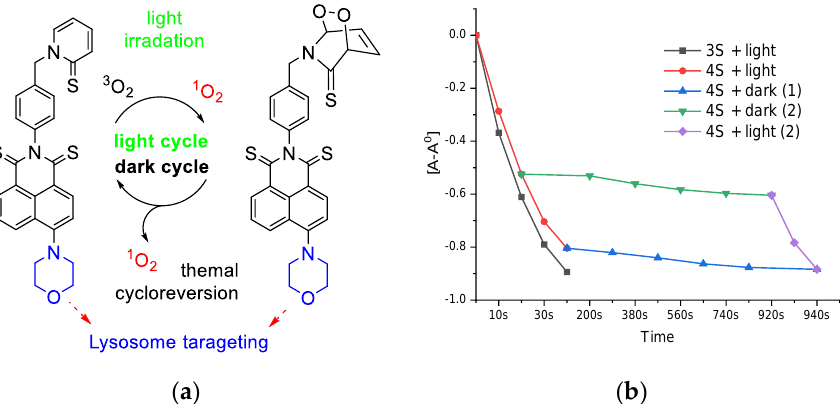
Figure 3. ( a ) Proposed mechanism of light/dark controlled release of lysosome-targeted heavy-metal-free PSs; ( b ) the decreased absorbance of DPBF ( 1 O 2 generation detector) (50 µM) in the presence of 3S (20 µM) and 4S (20 µM) under light/dark conditions.